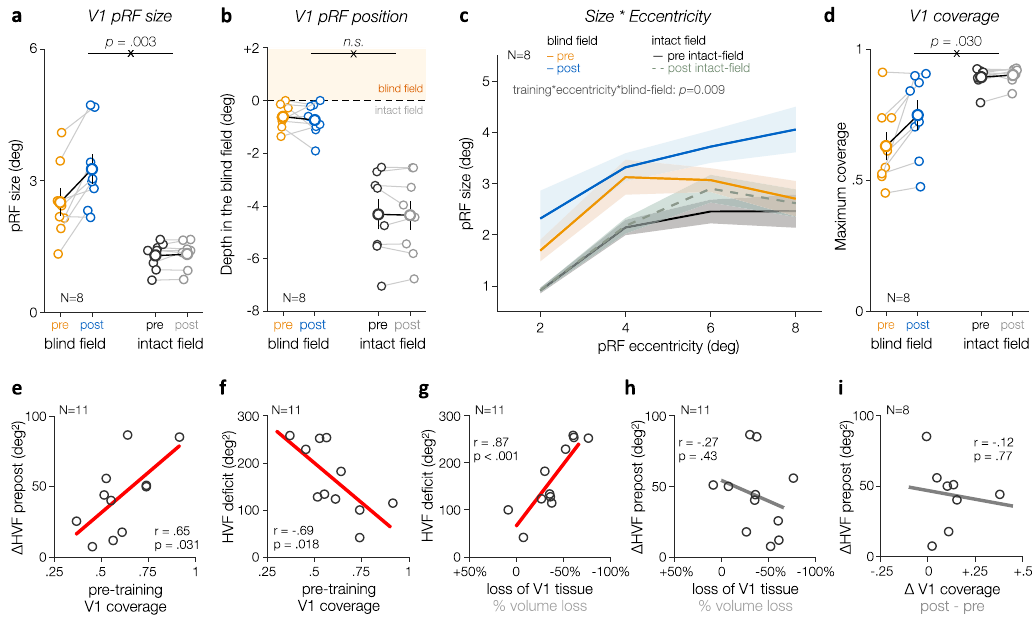
Fig. 7 Enhanced population receptive fi eld size and coverage of the blind fi eld in V1 following training. a Training in CB patients ( N = 8) resulted in a signi fi cant increase in pRF size for V1 pRFs covering blind- fi eld regions, compared to V1 pRFs covering solely intact- fi eld regions. Solid symbols show group- averaged estimates (±1SEM), and smaller dots individual data. Signi fi cant pRF coverage*training interaction (repeated-measures ANOVA) is indicated above the graph. b Training was not associated with a change in V1 pRF preferred position relative to the blind- fi eld border, expressed as the depth in the blind fi eld (in deg). Same convention as in ( a ). Moreover, training was not associated with changes in variance explained, pRF eccentricity or number of V1 pRFs (see Supplementary Figs. S5 and S6). c Prior to training, pRF size plotted as a function of eccentricity indicated larger pRF size for V1 pRFs covering parts of the blind fi eld, compared to V1 pRFs covering the intact fi eld. This difference decreased with eccentricity. Following training, pRF covering the blind fi eld increased in size, with this increase being more pronounced with eccentricity. Shaded areas correspond to ±1SEM. Data were binned as a function of eccentricity (2 – 8 deg with 2 ± 1 deg steps) for illustration purpose only; effects were assessed using a linear mixed-effects model. d Increase in the size of perilesional V1 pRFs resulted in enhanced V1 coverage of the blind fi eld following training. Same convention than ( a , b ). e Pre-training V1 coverage of the blind fi eld in CB patients ( N = 11) was predictive of the amount of HVF recovery observed within the inner 11.5 deg following training. The initial HVF de fi cit area (for the inner 11.5 deg) was anti-correlated with ( f ) the amount of pre-training coverage of the blind fi eld and ( g ) with the loss of V1 tissue (i.e., negative values indicate a stronger reduction in V1 volume between the intact and damaged hemispheres). h However, the loss of V1 tissue (and the size of the pre-training HVF de fi cit) did not correlate with the amount of HVF recovery observed following training. i Larger increase in V1 coverage of the blind fi eld (or in the size of V1 pRFs) was not associated with stronger HVF